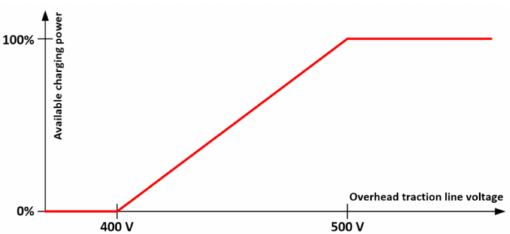
Figure 12. Proposed charging power reduction strategy for protection from the undervoltage